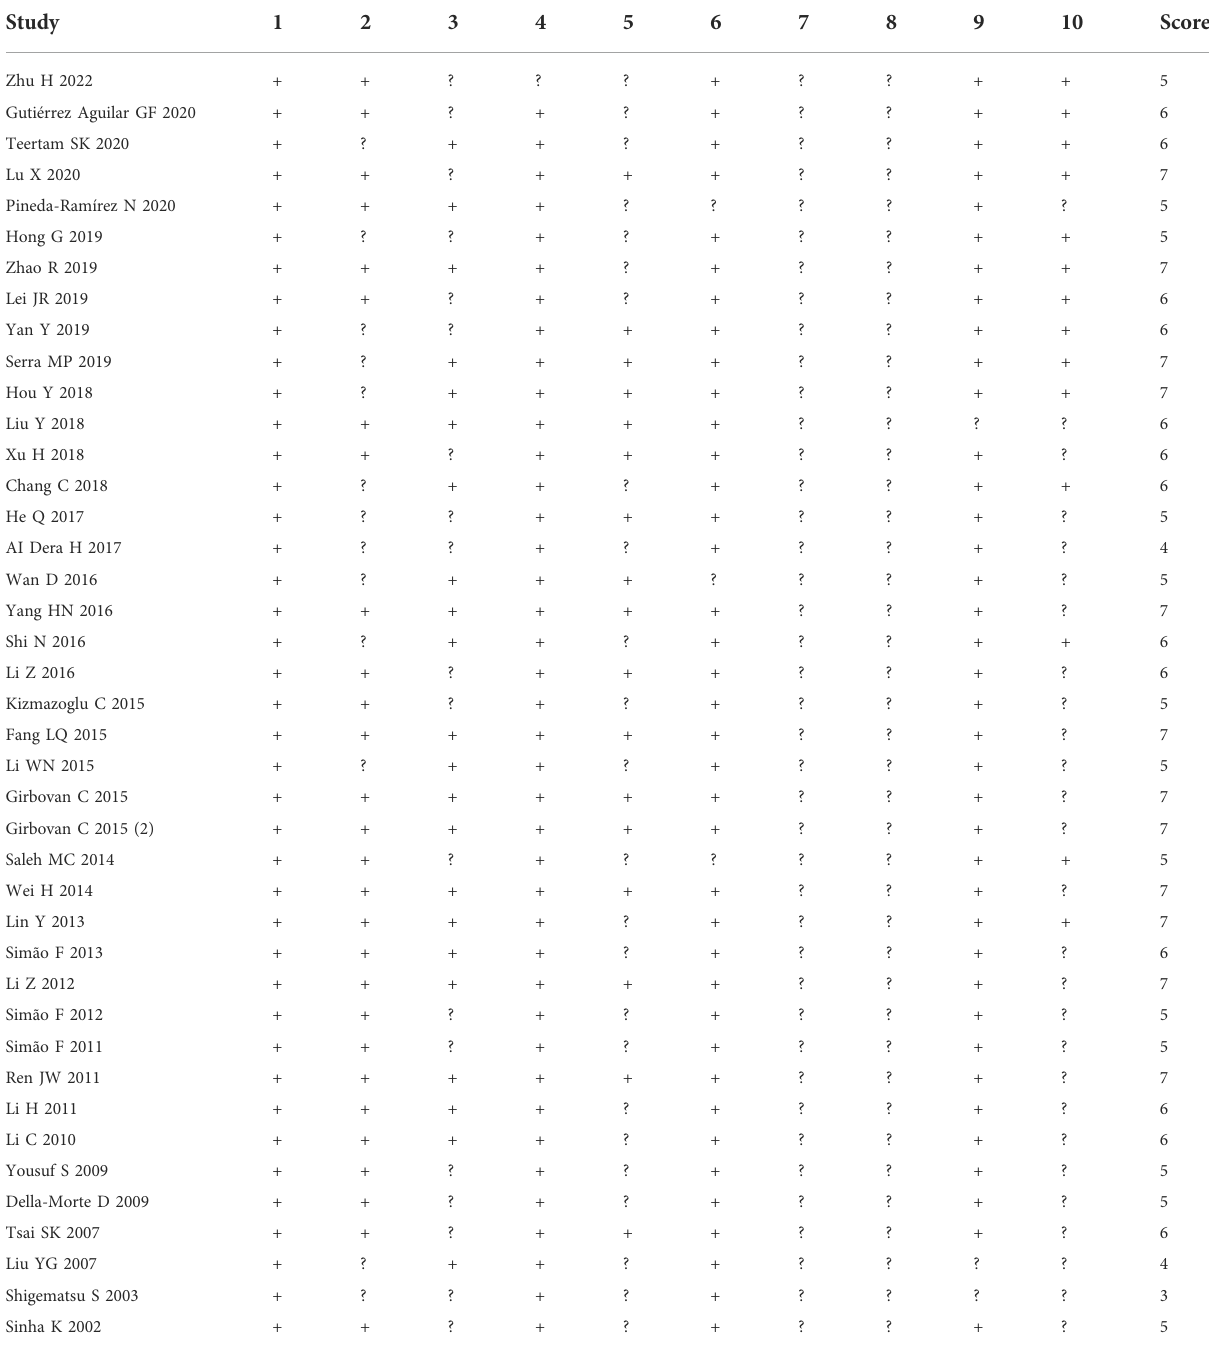
TABLE 2 Risk of bias